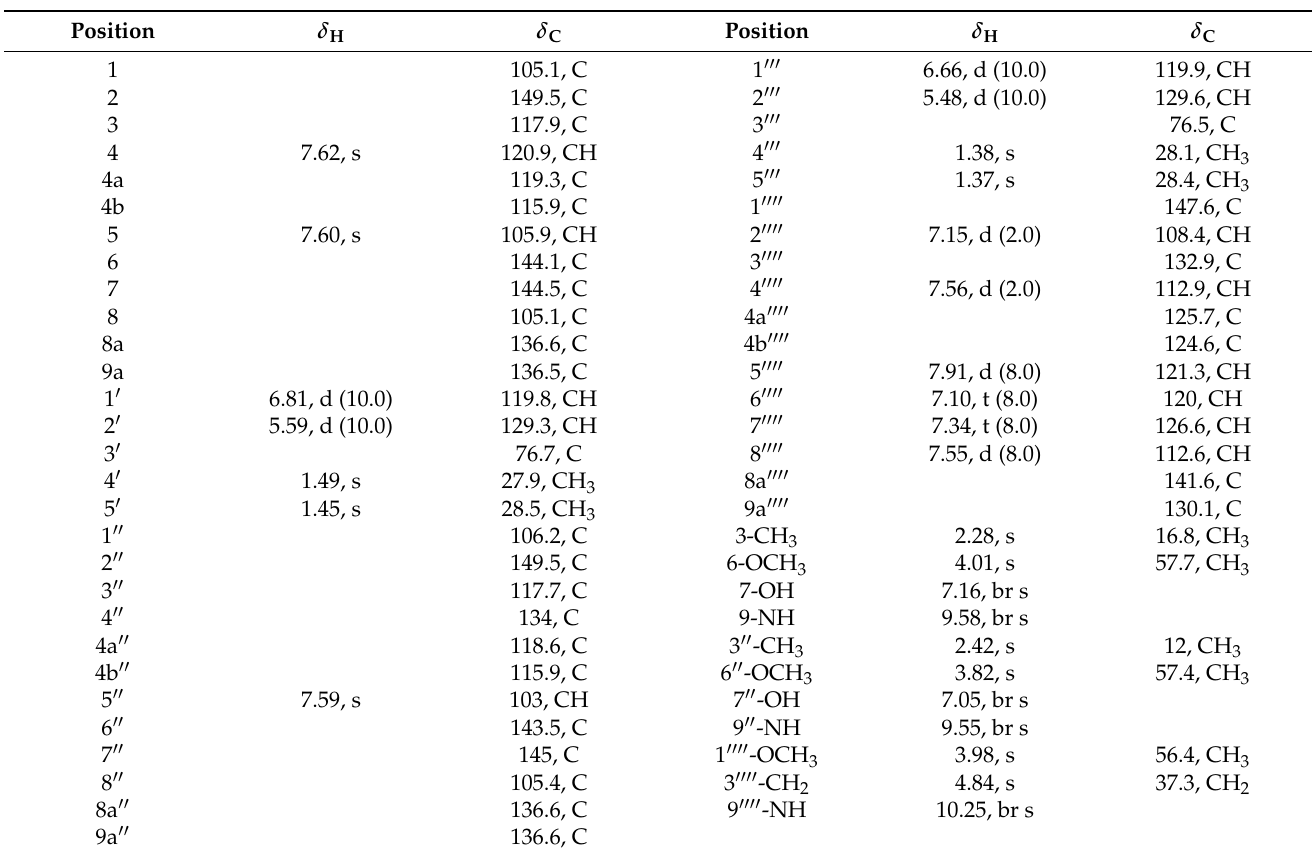
Table 1. 1 H nmR and 13 C nmR data of compound 1 in acetone- d 6 ( δ in ppm, J in Hz, 1 H nmR: 400 MHz; 13 C nmR: 100 MHz) a